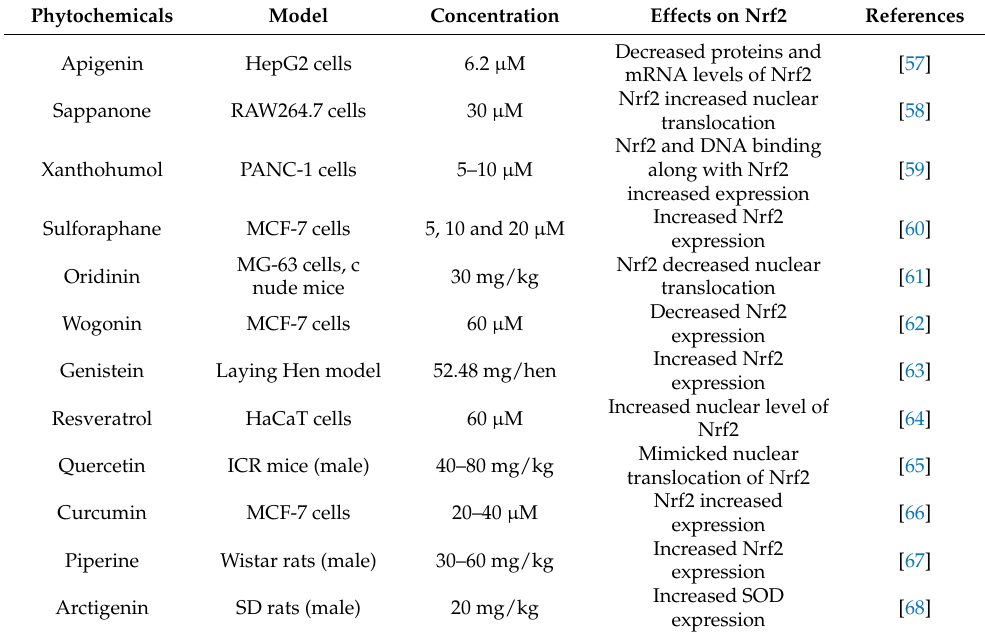
Table 1. Phytochemicals (non-nutrient) modulating Nrf2.